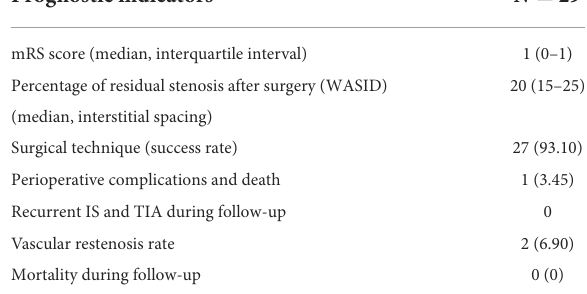
TABLE 2 Overall